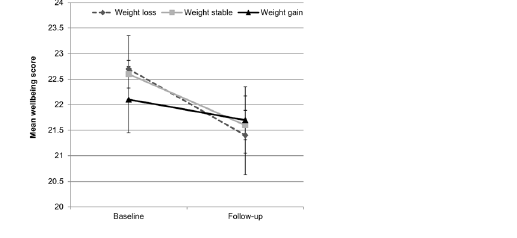
Figure 3. Mean wellbeing at baseline and follow-up by weight change status. Values are mutually adjusted for age, sex, wealth, and weight loss intention. Error bars represent the 95% confidence interval.